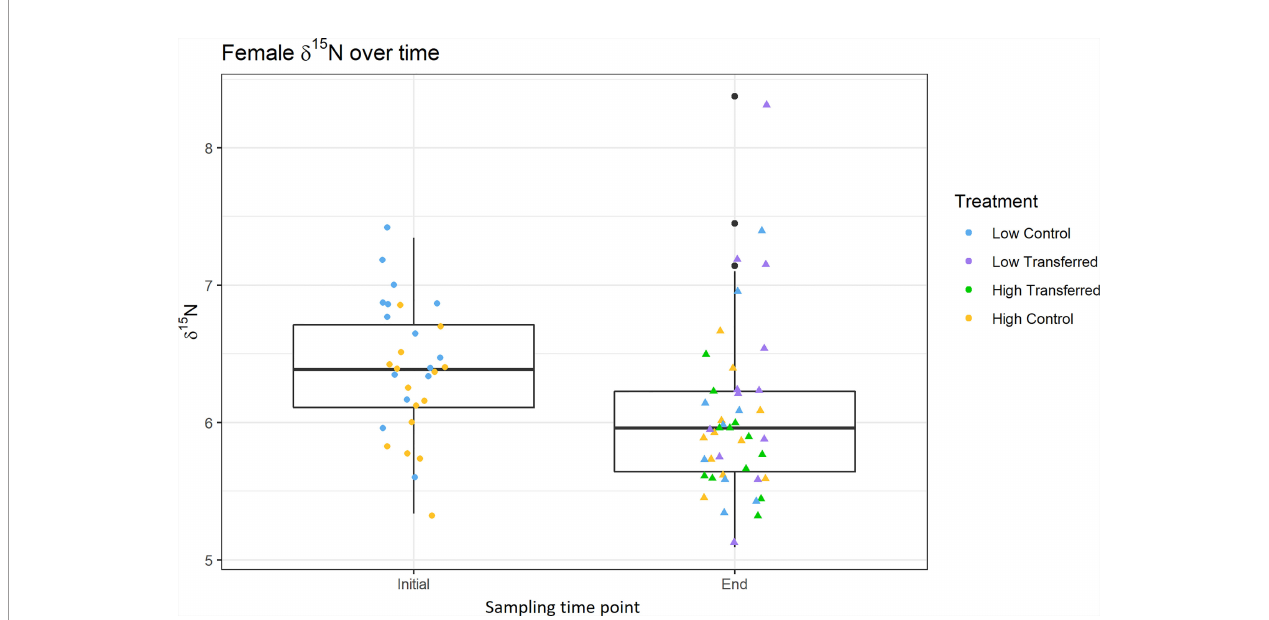
FIGURE 6 | d 15 N of females from initial samples (left) and end of experiment (right). Box plots include all treatments, points show the color of the treatment. See Figure 2 for experimental details.